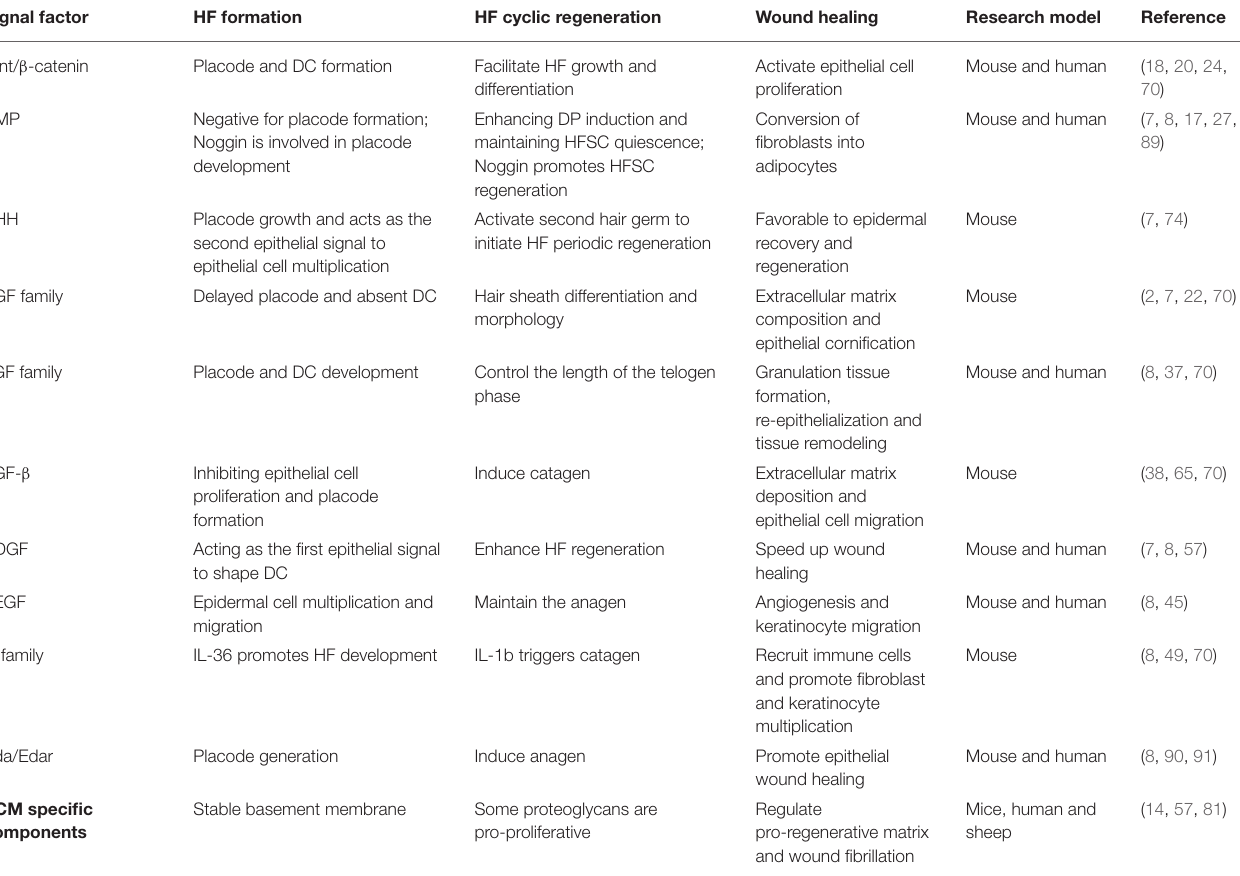
TABLE 1 | Signals in hair follicle regeneration and wound